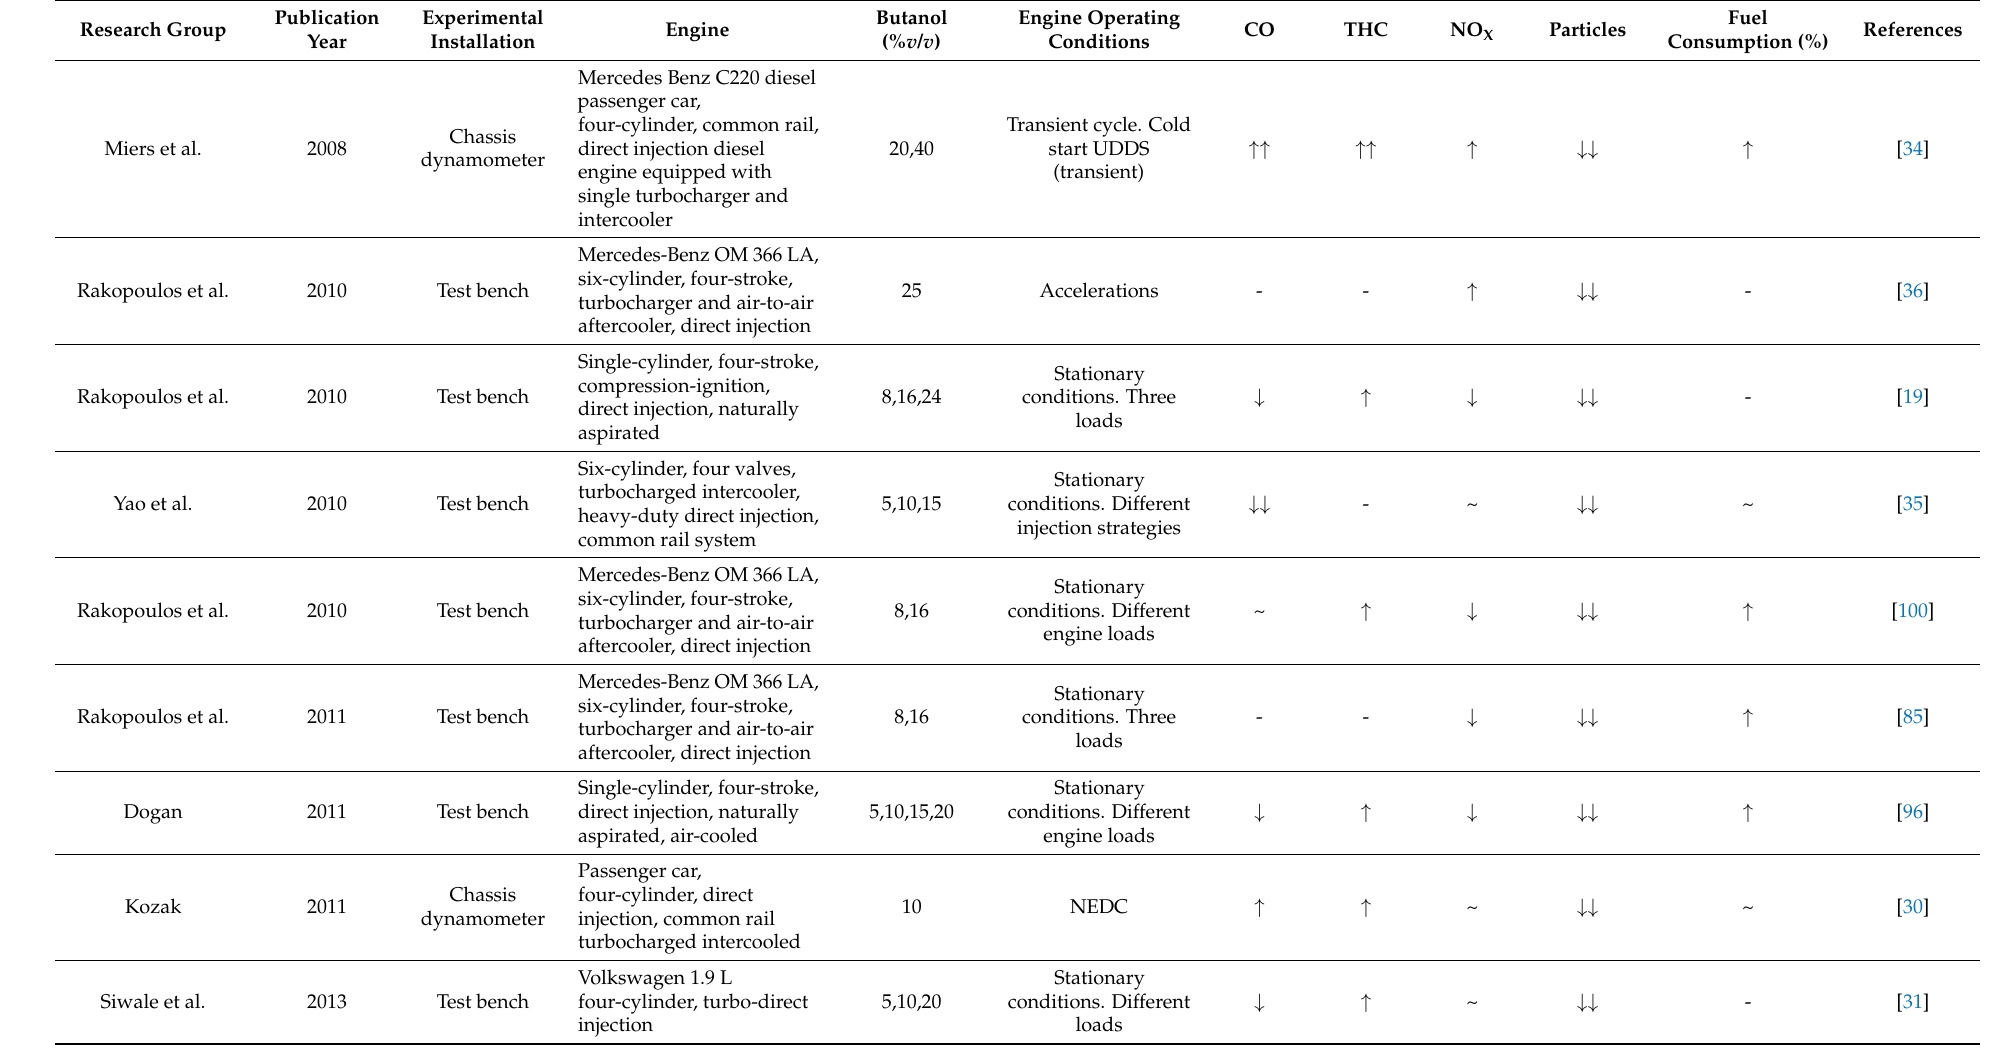
Table 2. Summary of butanol-diesel blends tested in diesel